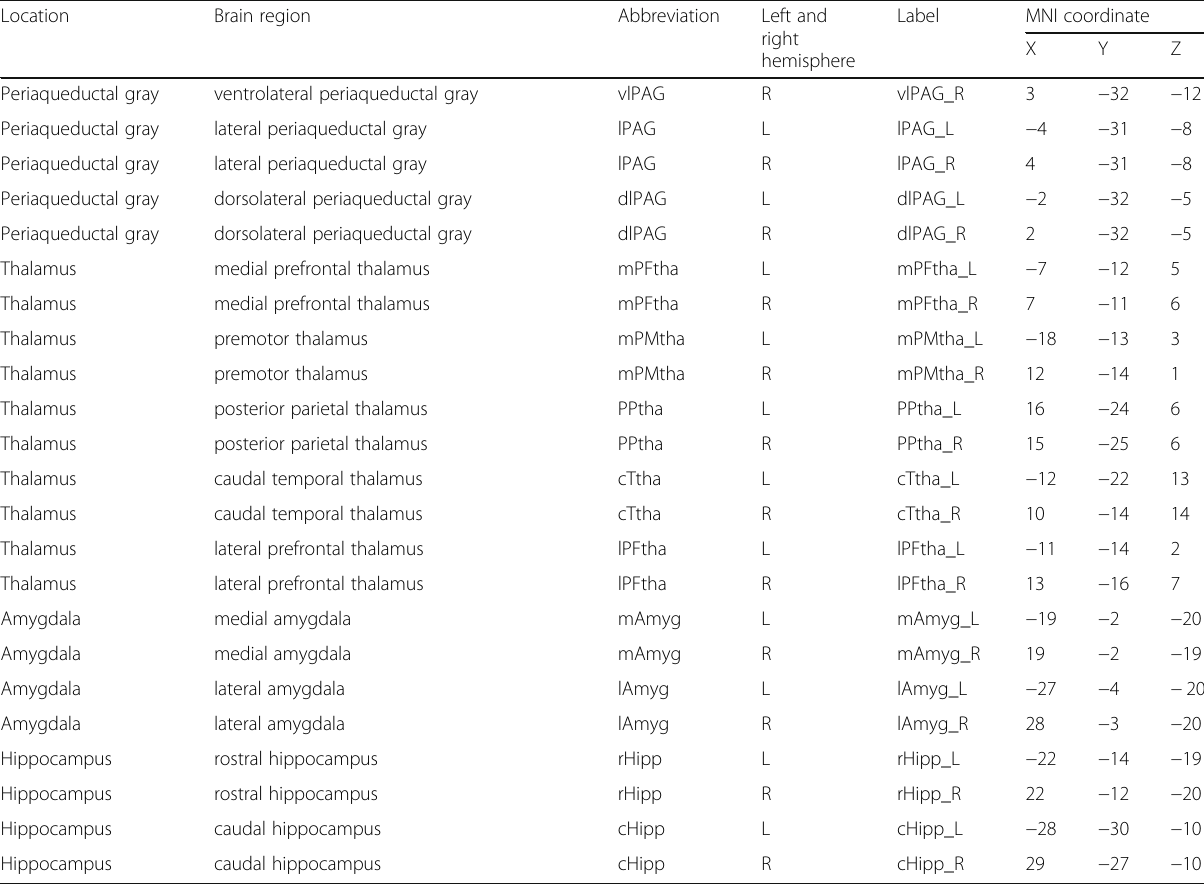
Table 2 MNI coordinates of the 64 selected pain-related brain regions